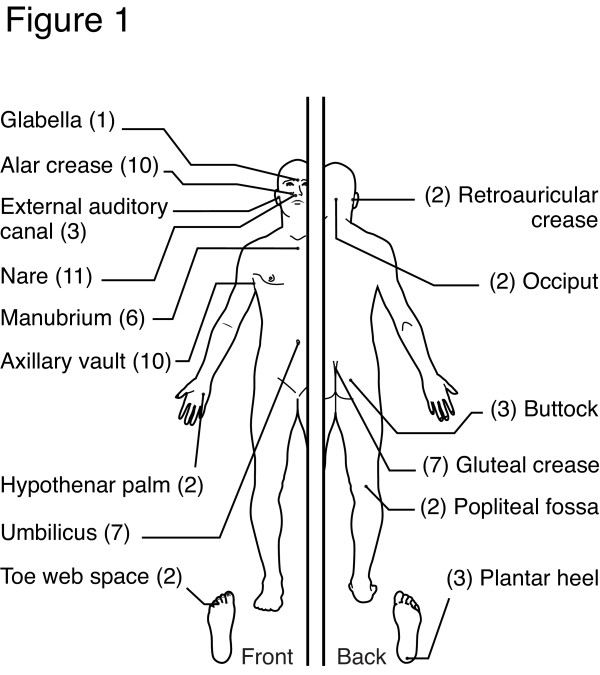
Body sites analyzed. A collection of 71 S. epidermidis isolates from 7 healthy volunteers across 15 body sites were selected for characterization (number of isolates from site in parenthesis).